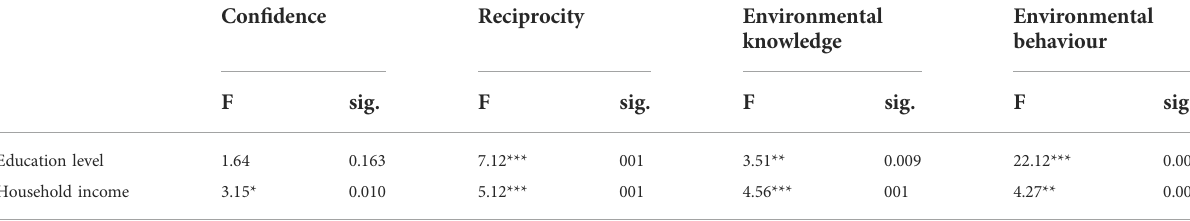
TABLE 4 Effect of educational attainment and household income on each dependent